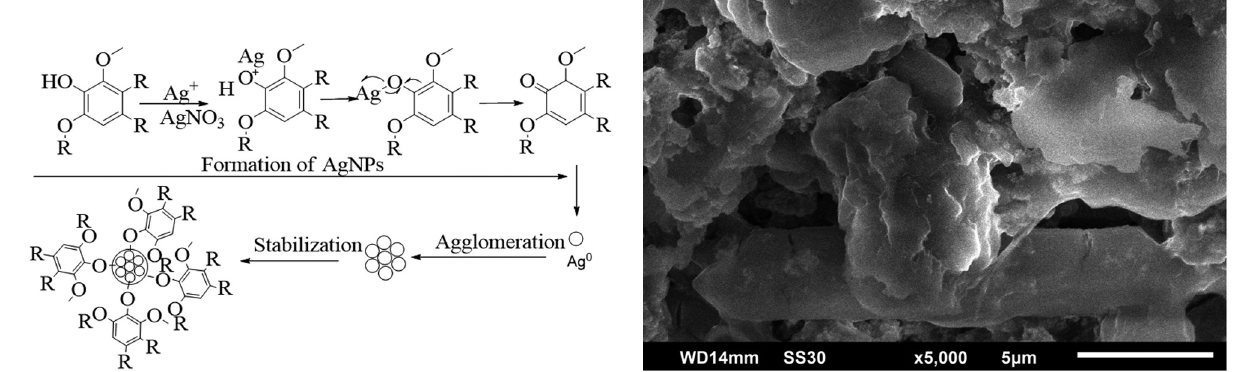
Figure 4: Tentative mechanism and stabilization of biogenic AgNPs. Figure 5: SEM image of the synthesized